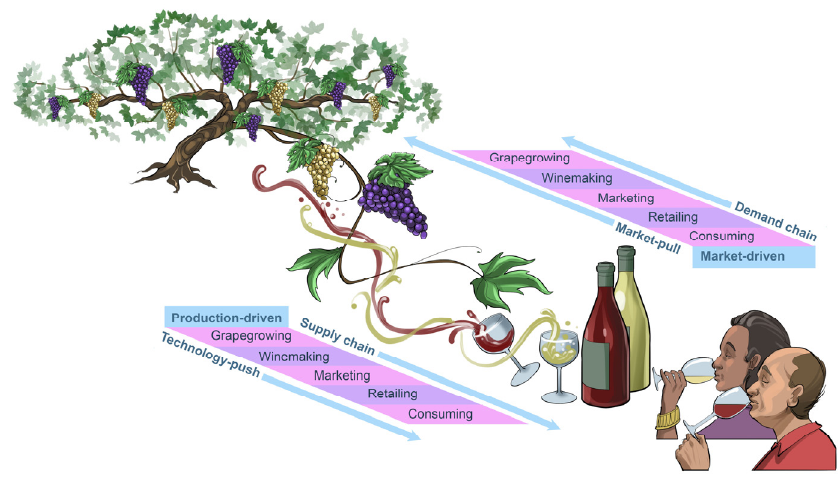
Figure 4. The value chain in wine production. The traditional production-driven view of the supply chain has been largely replaced by a more contemporary market-driven approach in a demand-chain scenario. This paradigm shift in the wine industry has placed its product at the centre of an arena between the forces of market-pull and technology-push , where tradition and innovation must co-exist [6]. Modern-day consumers demand wines that are enjoyable in all sensory aspects, healthful and produced in an environmentally sustainable manner and which measure up to the standards of wine’s indefinable mystique. In a globalised economy in which quality is defined as ‘sustainable customer and consumer satisfaction’, it is a struggle to deliver wines that meet these expectations at competitive quality/price ratios while remaining profitable. In a fiercely competitive marketplace with ever-changing consumer preferences, producers have to be constantly on the lookout for ways to anticipate new market trends and to be able to deliver products that meet the expectations of consumers in a timely fashion.